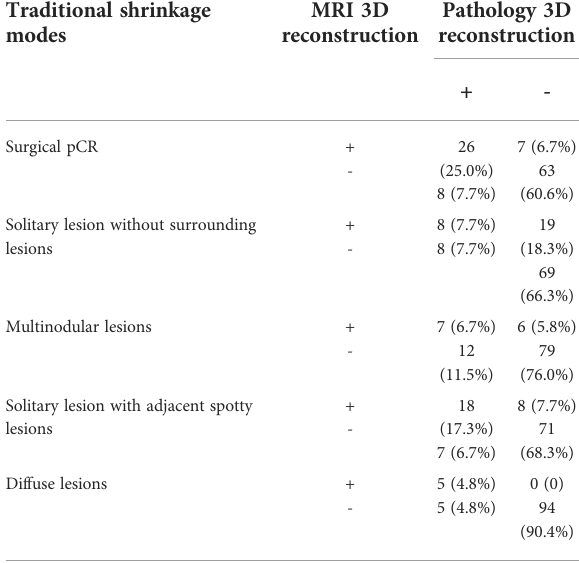
TABLE 4 The traditional shrinkage modes after NAT between MRI and pathology 3D